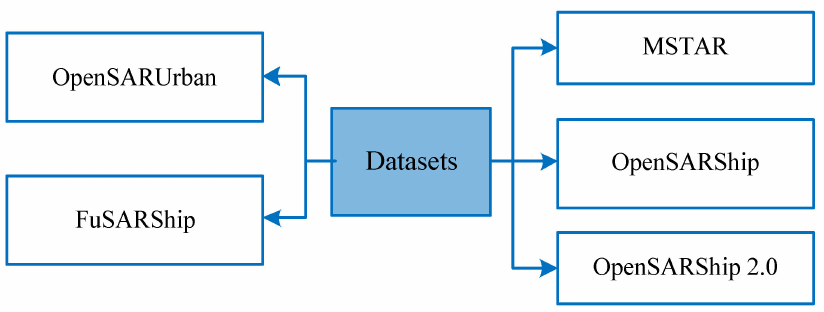
Figure 4. The datasets used in SAR